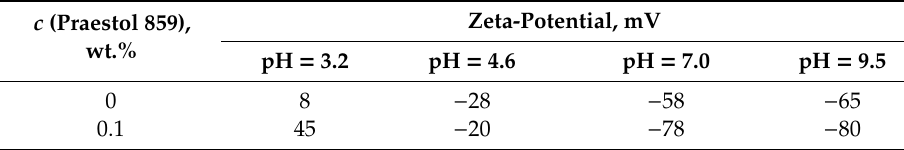
Table 5. Zeta-potential of the selective layer of reference PSF and PSF membranes, prepared using Praestol 859 aqueous solutions as coagulants. c (Praestol